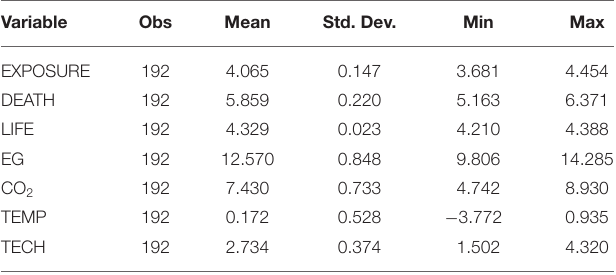
TABLE 2 | Descriptive statistics. Variable